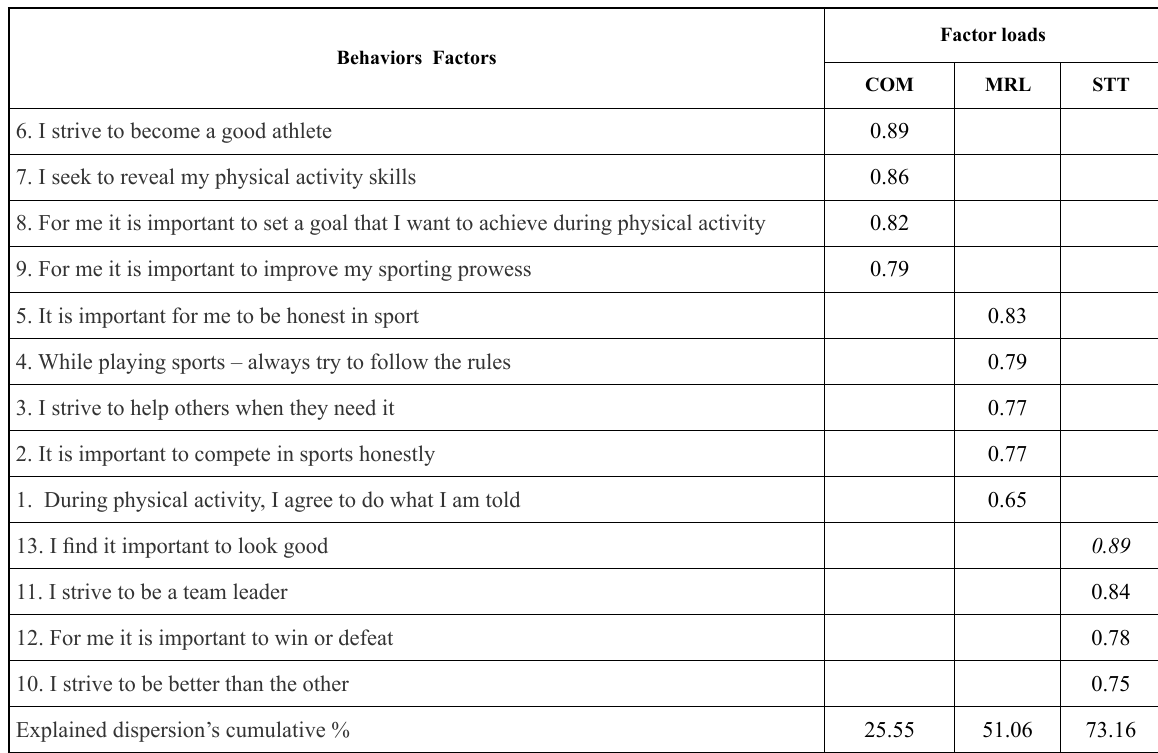
Table 1. Items and factor loading for Youth Sport Values Questionnaire (YSVQ) (n =